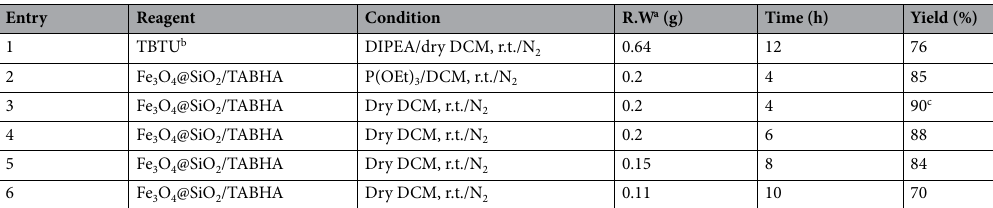
Table 2. Reaction optimization by utilizing different amounts of nanocatalyst. a Reagent weight. b O -(benzotriazol-1-yl)-N,N,N ′ ,N ′ -tetramethyluronium tetrafluoroborate. c Optimum conditions.